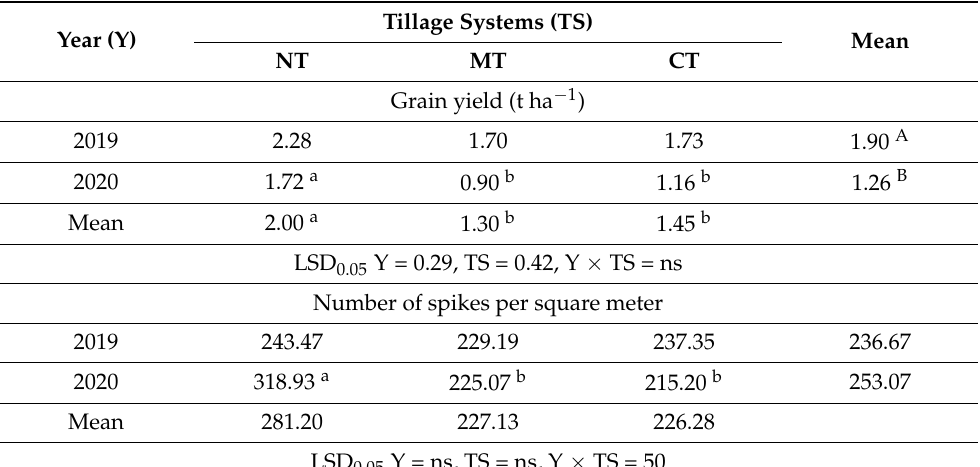
Table 3. Influence of soil tillage systems on grain yield and its components, during the 2019 and 2020 growing seasons ( p <